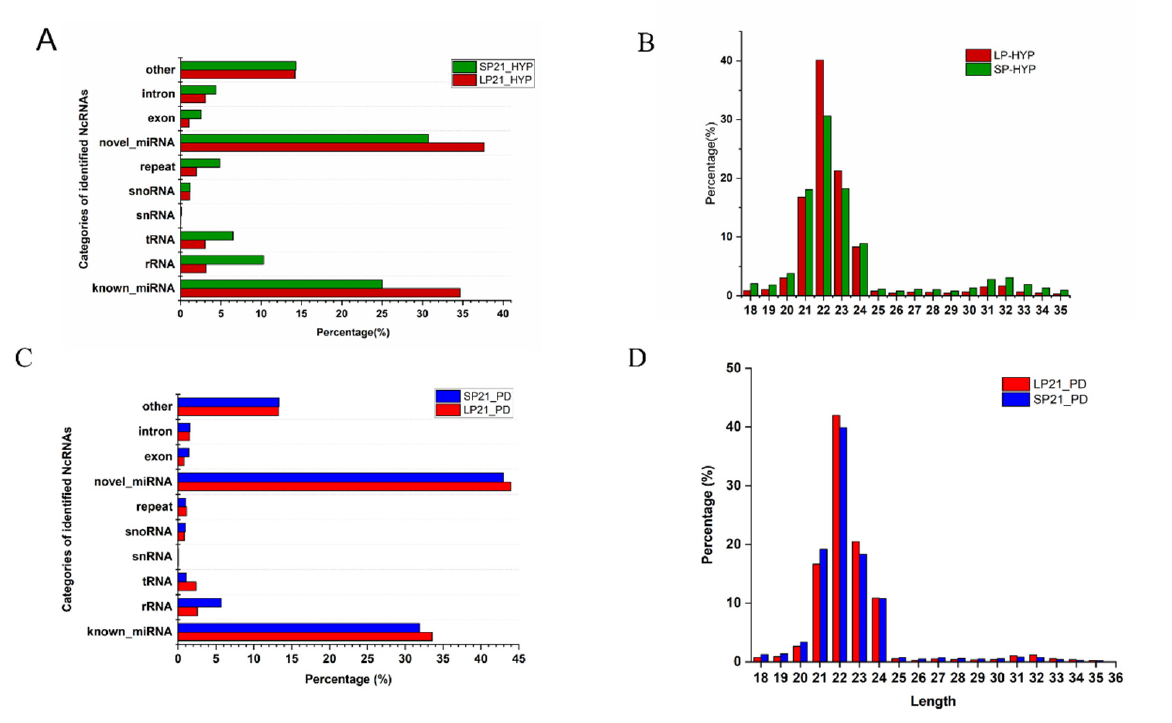
Figure 2. Types of non-coding rRNAs ( A )and length distribution of sRNAs ( B ) from SP21 − HYP vs. LP21 − HYP, ( C , D ) from SP21 − PD vs. LP21 − PD.